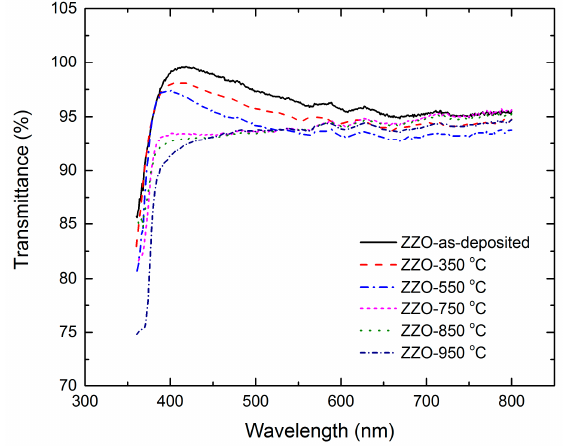
Figure 5. Optical transmittance as a function of wavelength for as-deposited and annealed ZnO:Zr films.